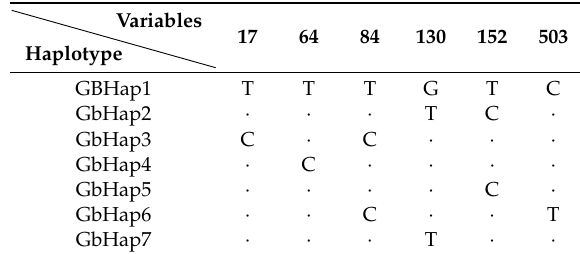
Table 1. Variable sites of seven haplotypes of G. boninense